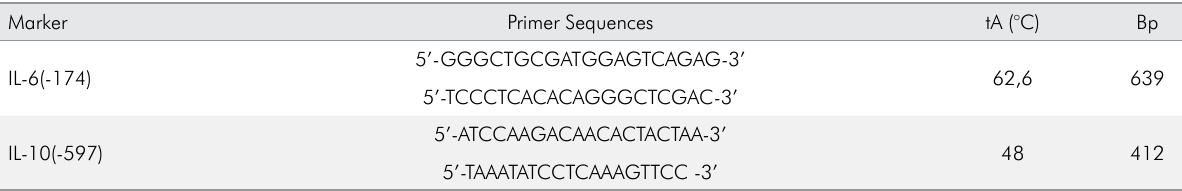
Table 1. Primer sequences and reaction properties for genes. Marker Primer